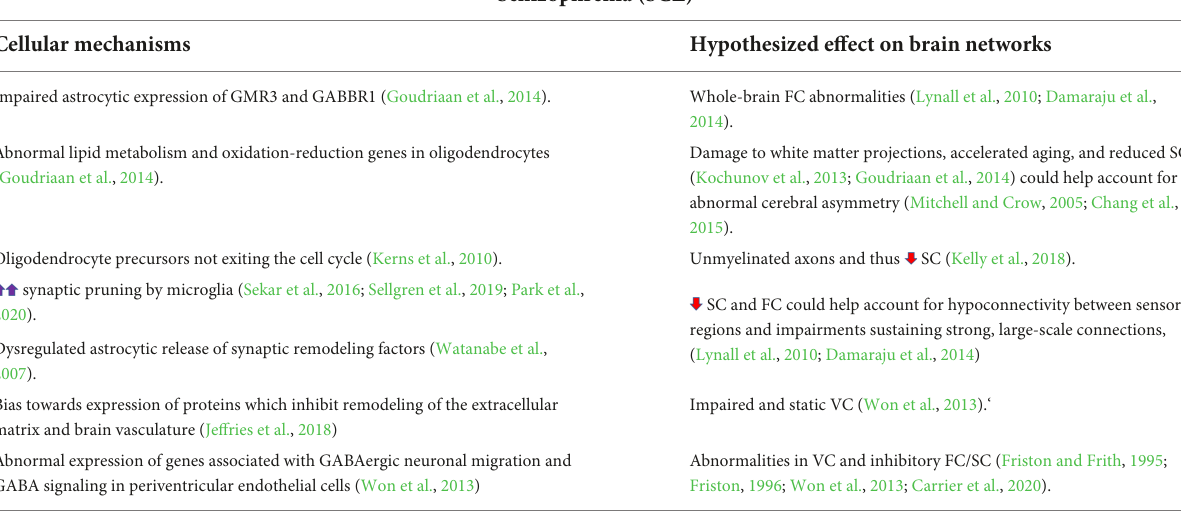
TABLE 2 Summary of the cellular mechanisms found in disorder of consciousness and their suggested effect on the brain. Disorder of consciousness (DOC) Cellular mechanisms Hypothesized effect on brain